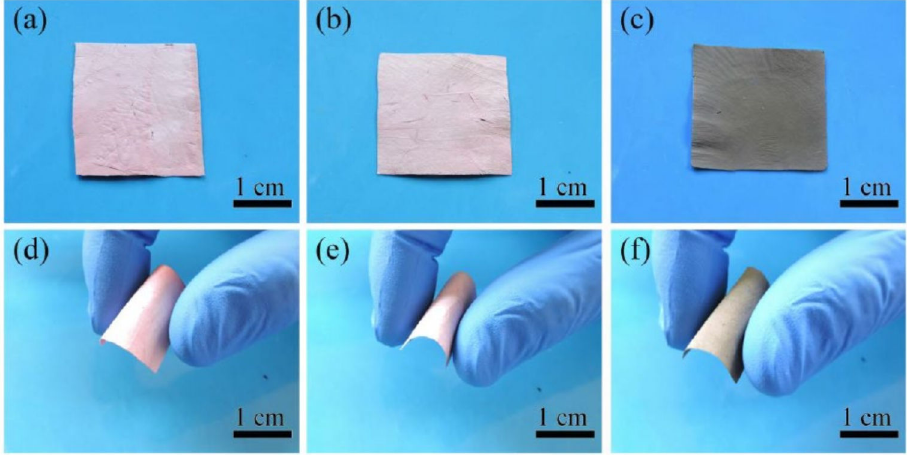
Figure 6. Photographs of nanofibrous membranes of SiO 2 @Au-20 ( a , d ), T-A@SiO 2 @Au-20 ( b , e